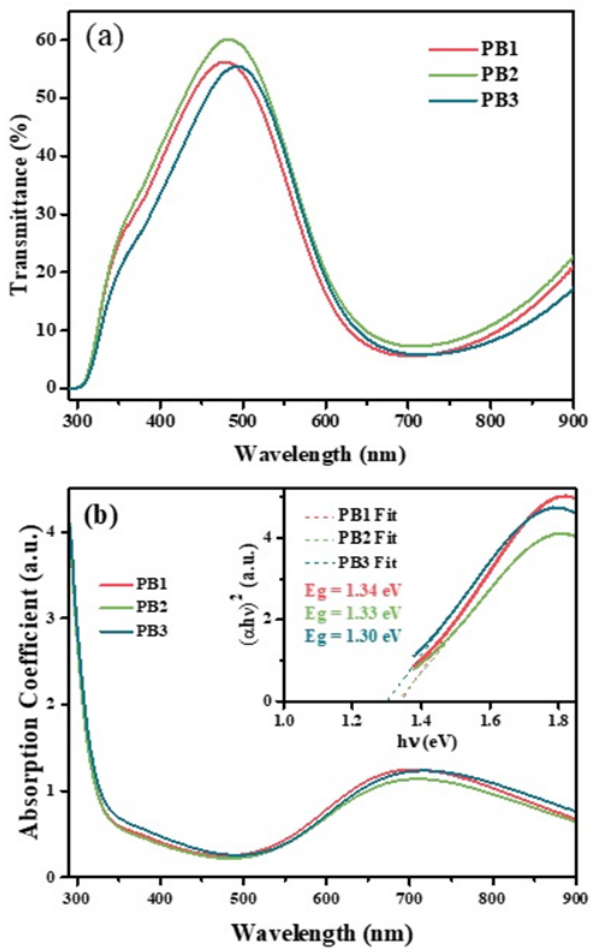
Figure 6. ( a ) Transmittance spectra and ( b ) absorption coefficient ( α ) of the PB films. The inset of ( b ) shows the Tauc plot for the bandgap determination.